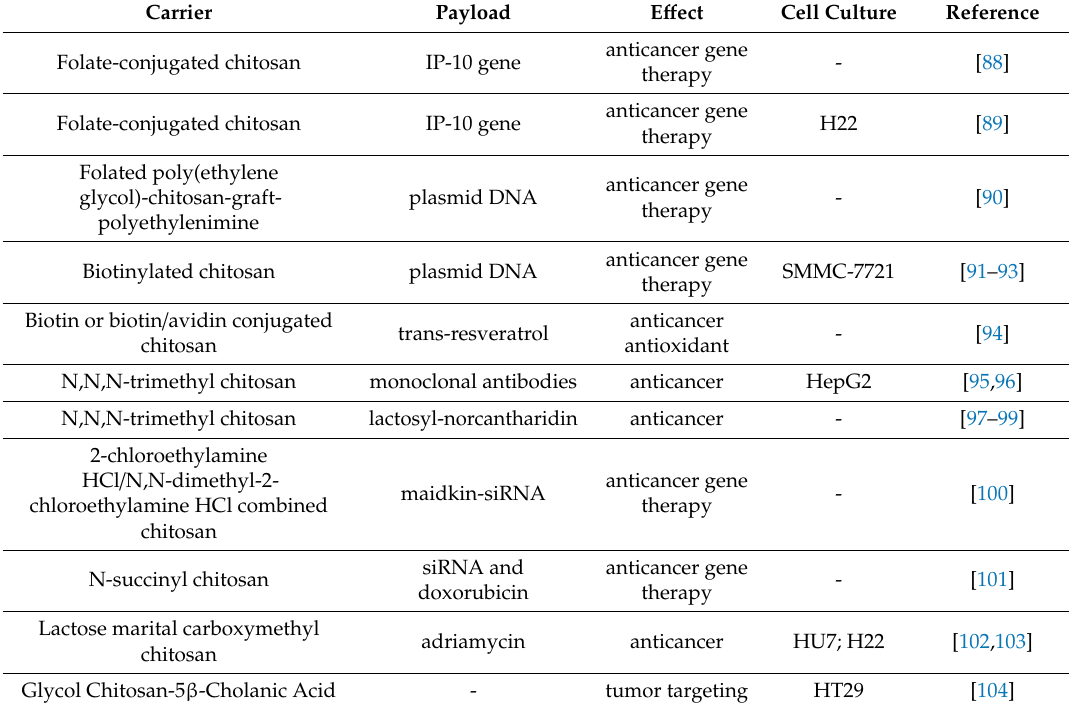
Table 4. Nanoparticles made of chitosan derivatives for the treatment of HCC and liver-targeting: the therapeutic / theranostic e ff ect and cell cultures used in the study are reported for each reference.